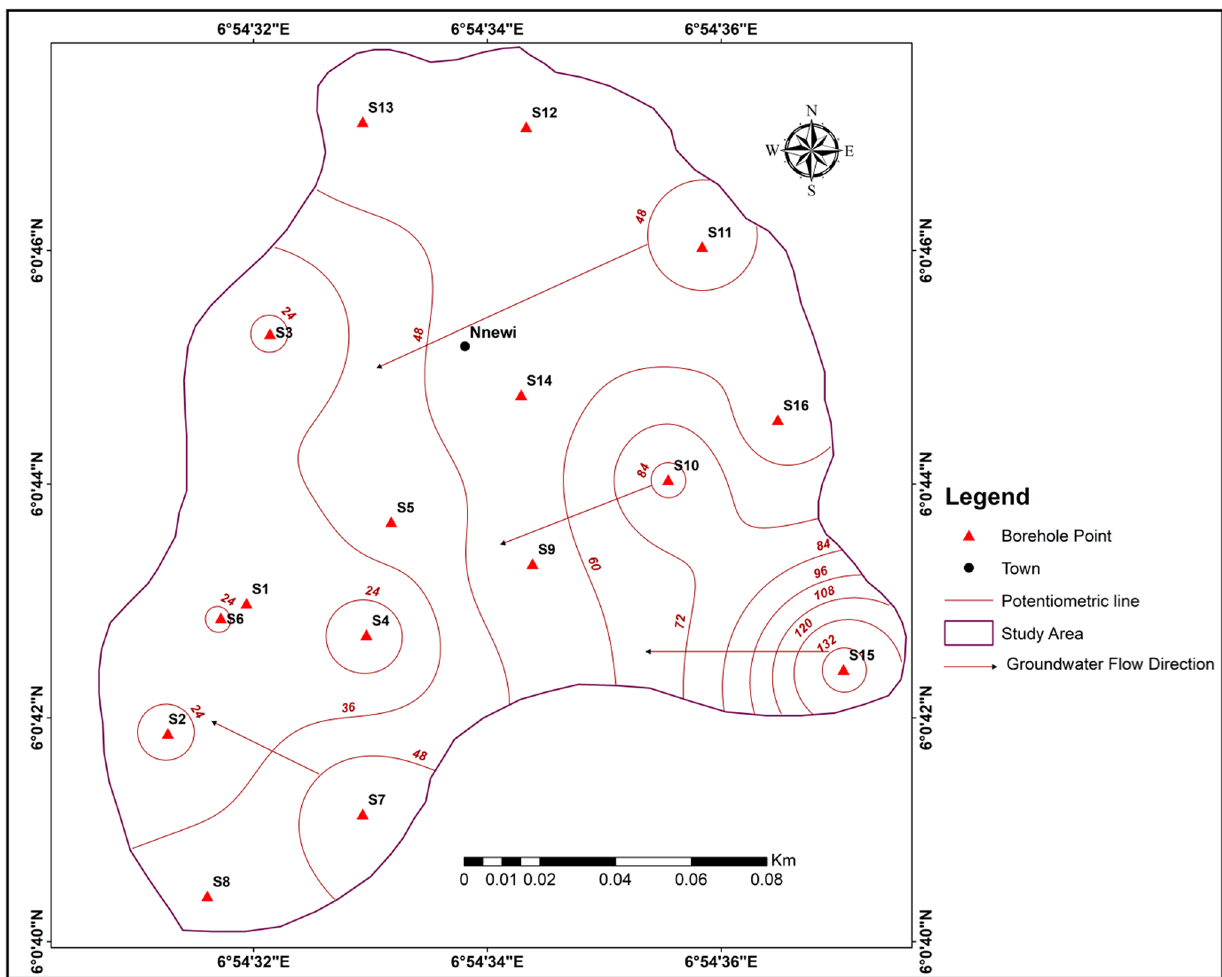
Fig. 2 Potentiometric map of the study